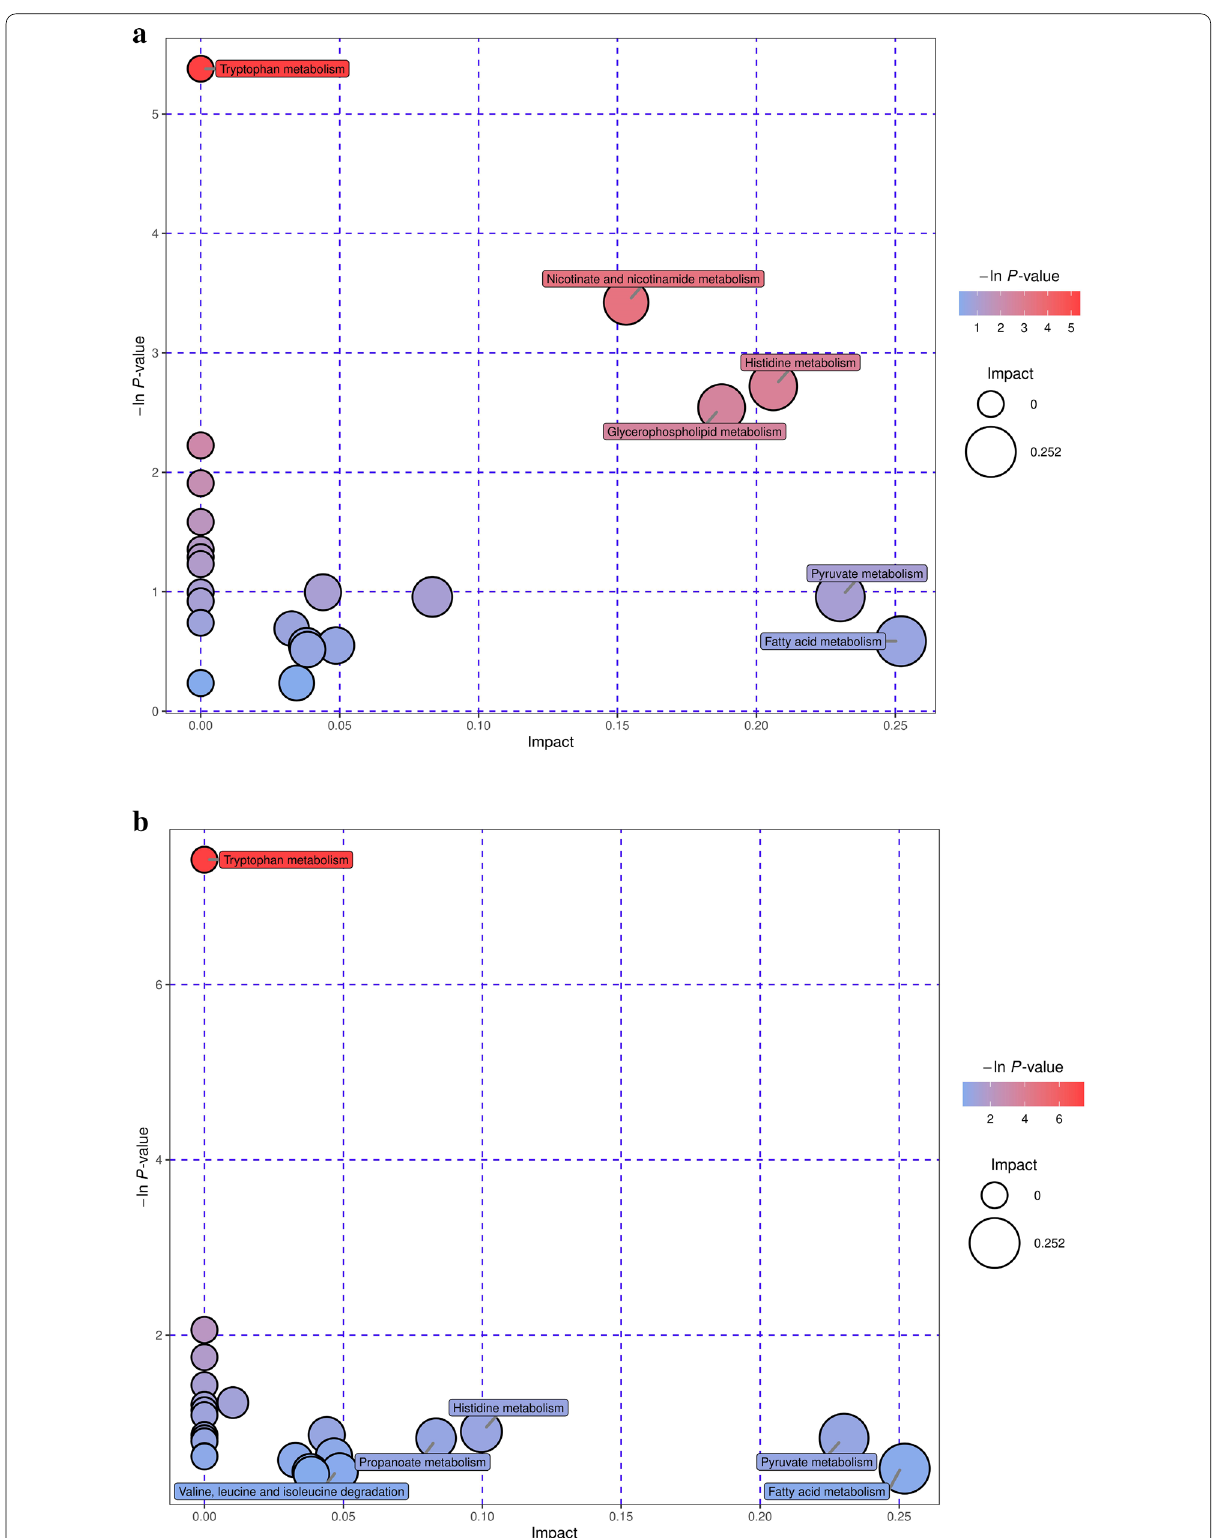
Fig. 7 Pathways analysis for recombinant B. subtilis and E. coli . a , b extracellular and intracellular pathways of differential metabolites of B. subtilis ; c , d extracellular and intracellular pathways of differential metabolites of E.